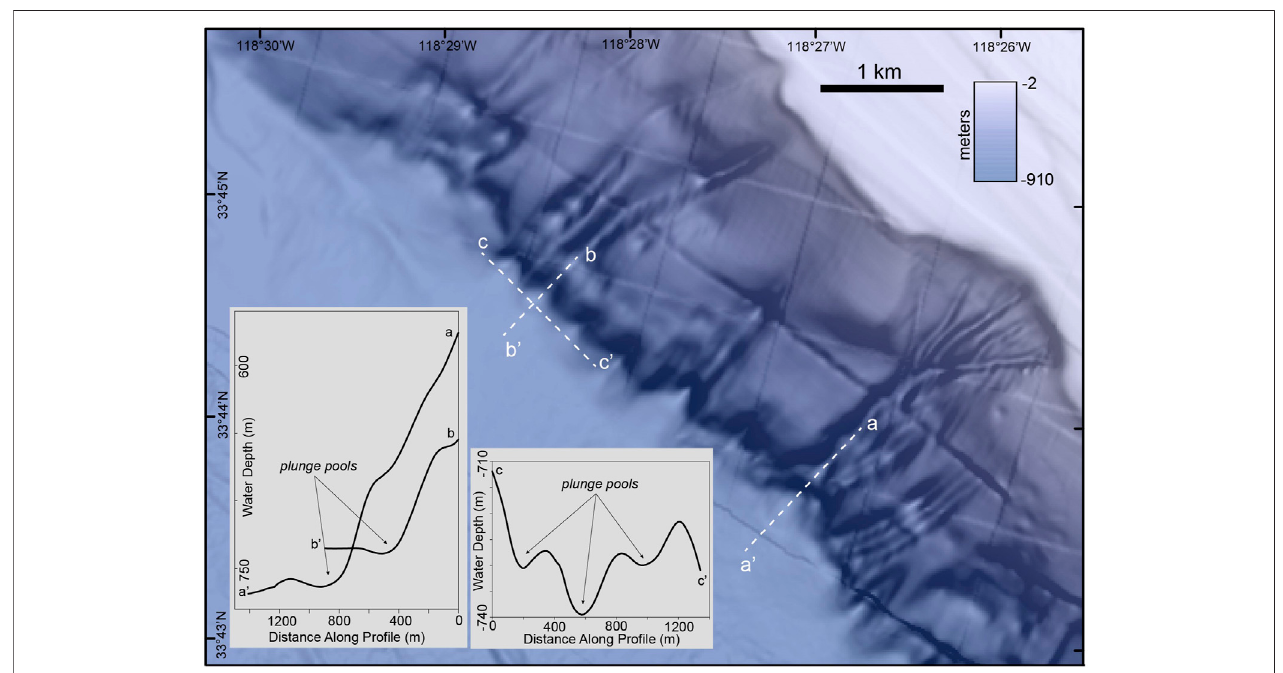
FIGURE 5 | Plunge pools at the base of slope, offshore Southern California. Map shown is colour-contoured multibeam bathymetry draped over slope-shaded bathymetry. Bathymetric grid (16 m) from Gardner and Dartnell (2002) and plunge pool interpretations after Lee et al. (2002).